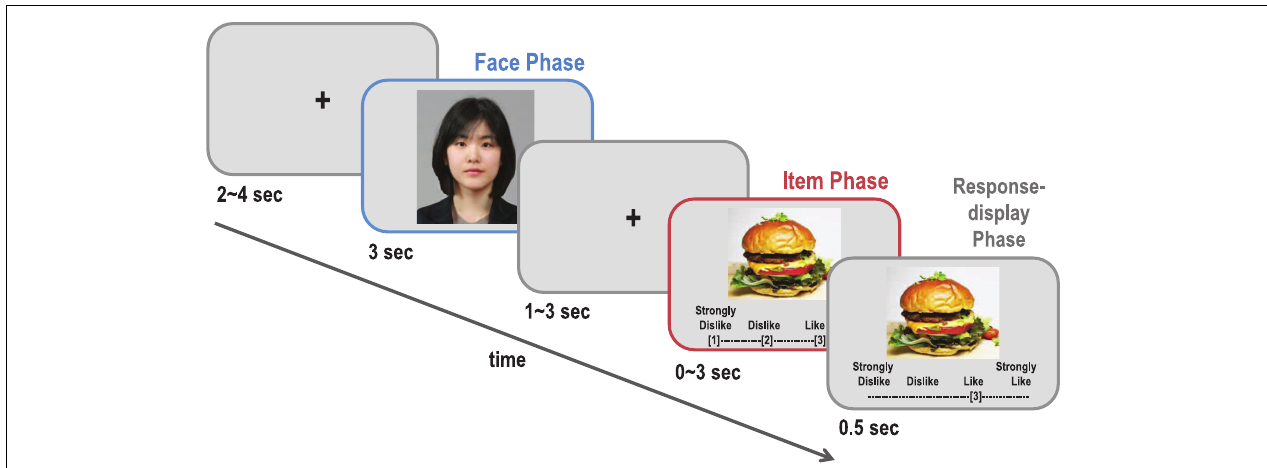
FIGURE 1 | A schematic diagram of a typical trial in the preference estimation task. In each trial, the participants (Perceivers) were asked to guess each target’s actual preference for a given item. The target’s face photo (perceiver’s face photo) was shown for 3s in the target-trials (self-trials), and a photo of the item was displayed after